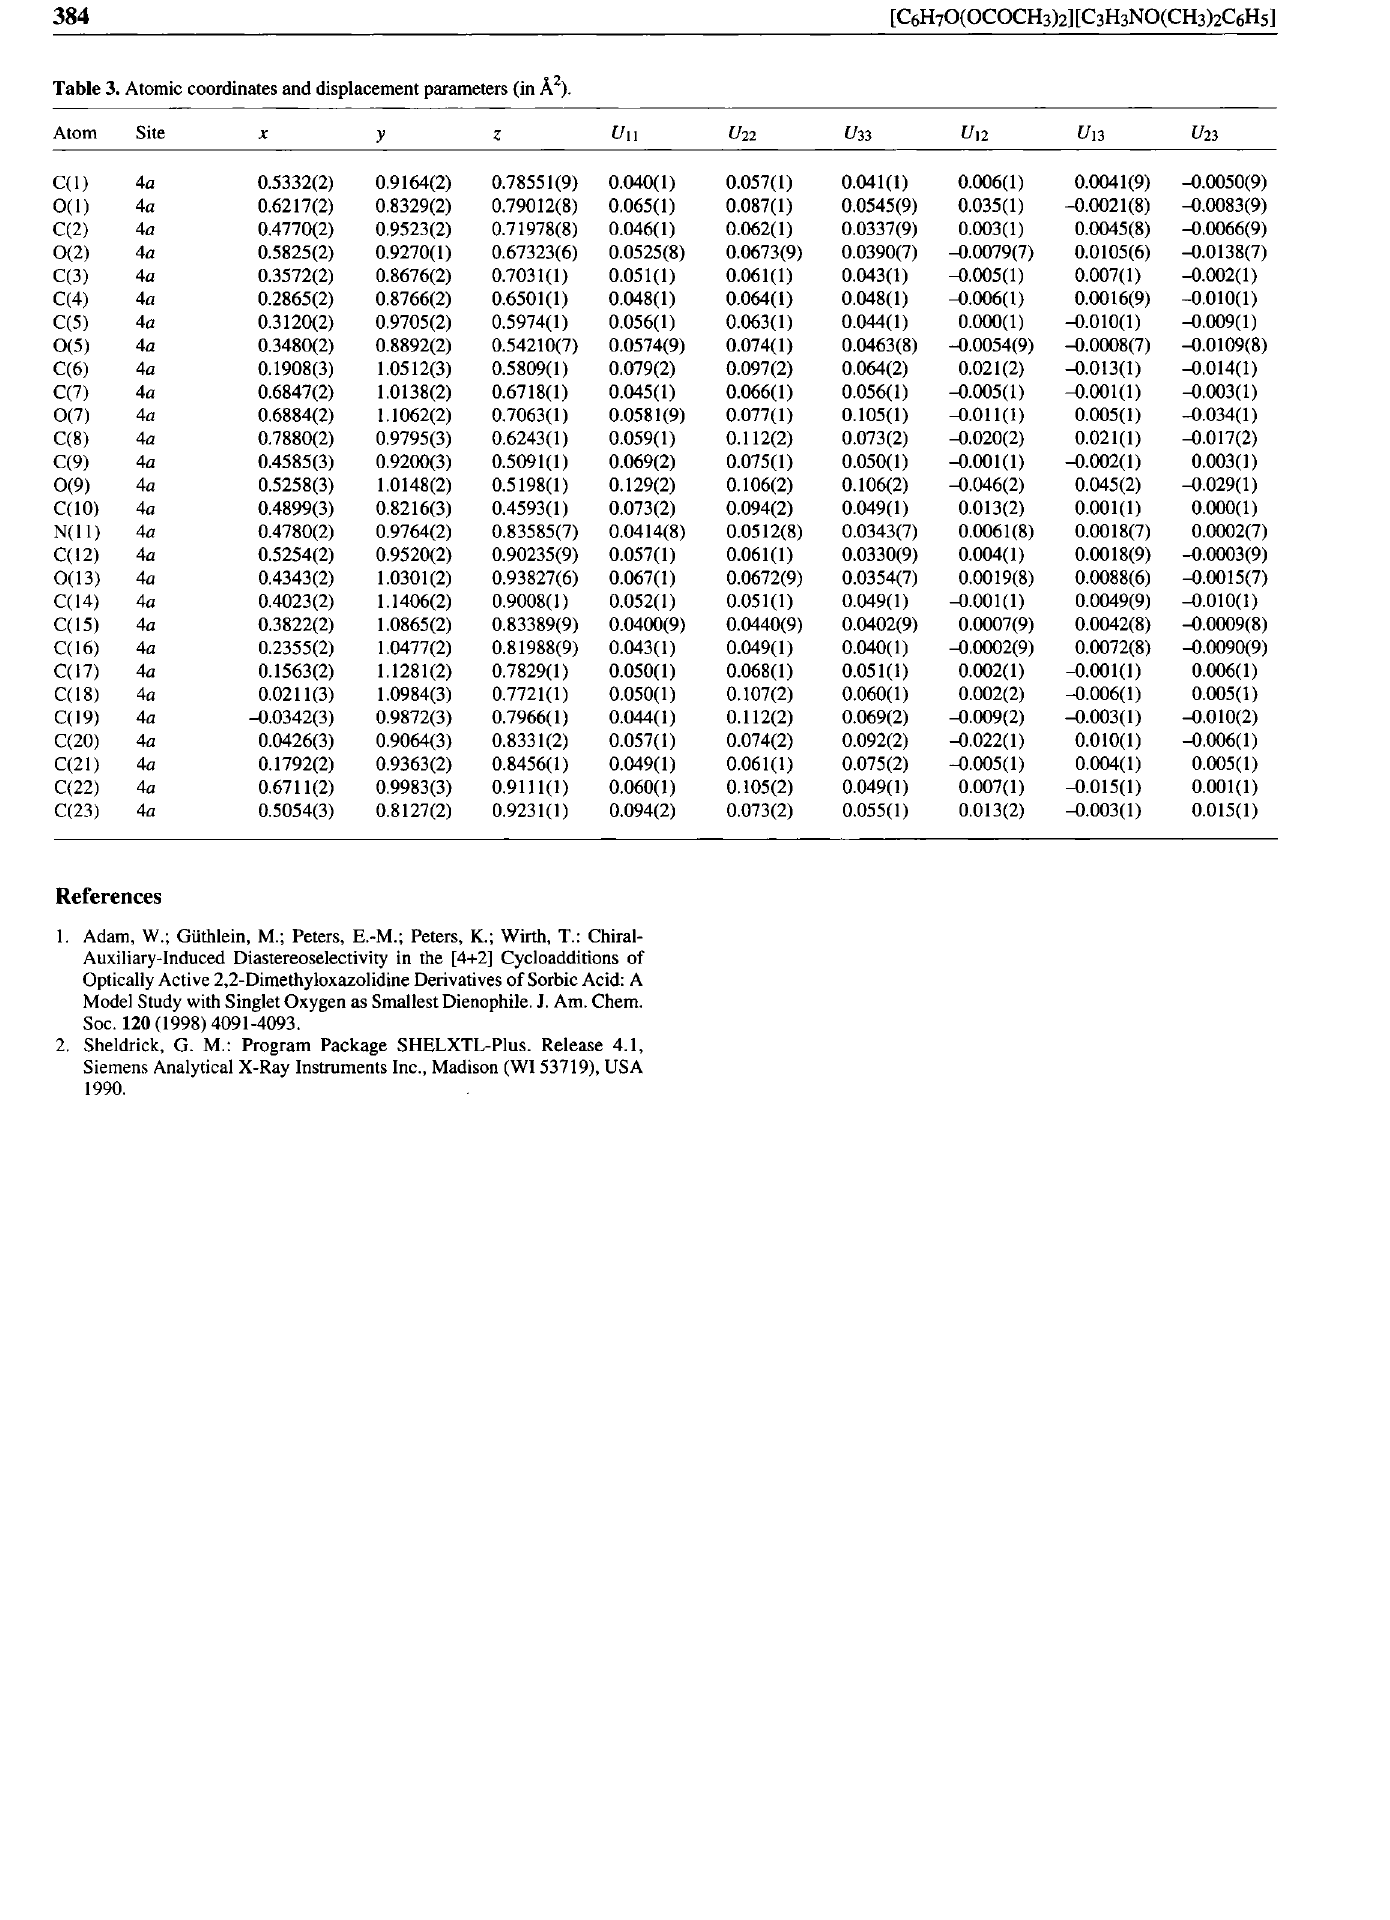
Table 3. Atomic coordinates and displacement parameters (in Ä 2